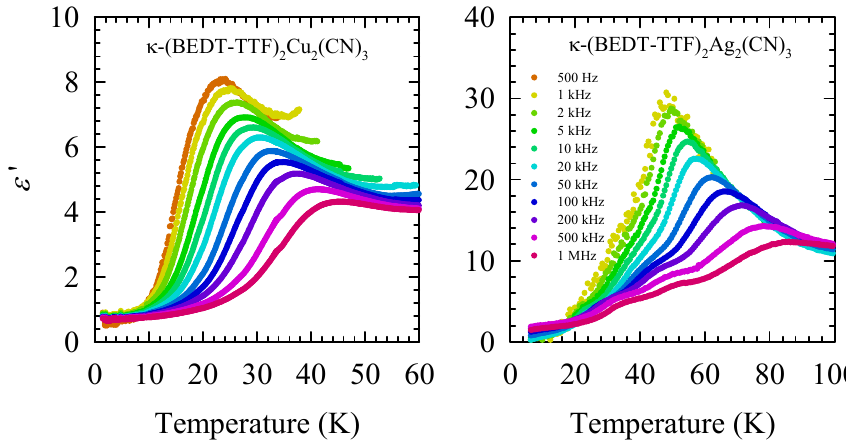
Figure 9. Real part of the dielectric function ε (cid:48) as a function of temperature with the ac electric field applied E (cid:107) a ∗ for single crystals of: κ -CuCN ( Left ); and κ -AgCN ( Right